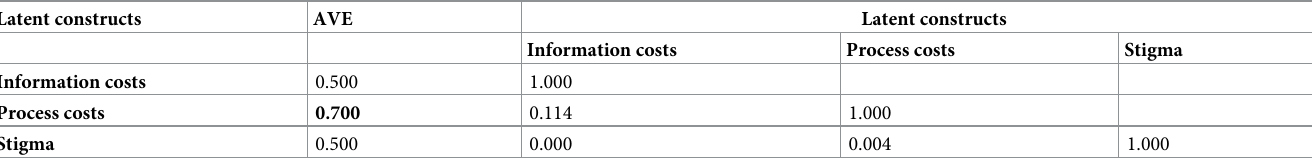
Table 5. Average variance extracted (AVE) and squared inter-construct correlations (Sample 2, n = 1265). Latent